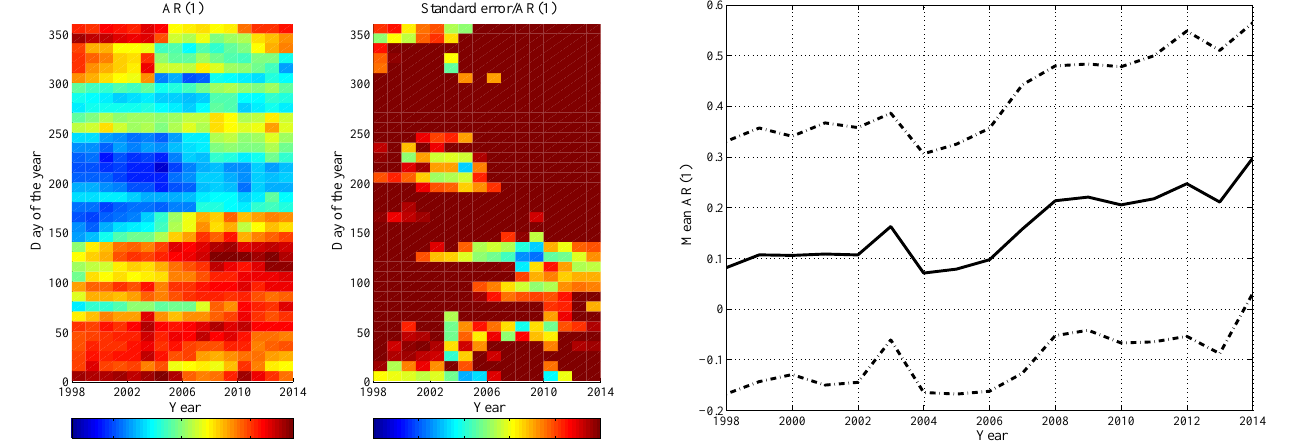
Figure 12. Left panel: Lag 1 autocorrelation of the return map against sliding window end year using a sliding window of 20years ( x axis) and point within the cycle the return map is created on the y axis (we create return maps every 10days). One sees that auto- correlation depends very heavily on where in the cycle one chooses to generate the return map. Right panel: standard error of the au- tocorrelation return map estimate divided by the estimate against sliding window end year. The estimate is very uncertain almost ev- erywhere with standard errors generally being at least half as big as the estimate.